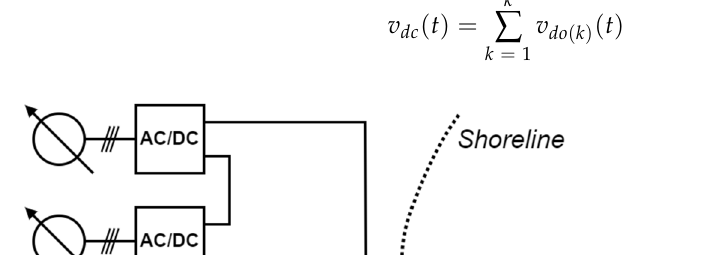
Figure 8. Parallel DC collection grid with an offshore hub.